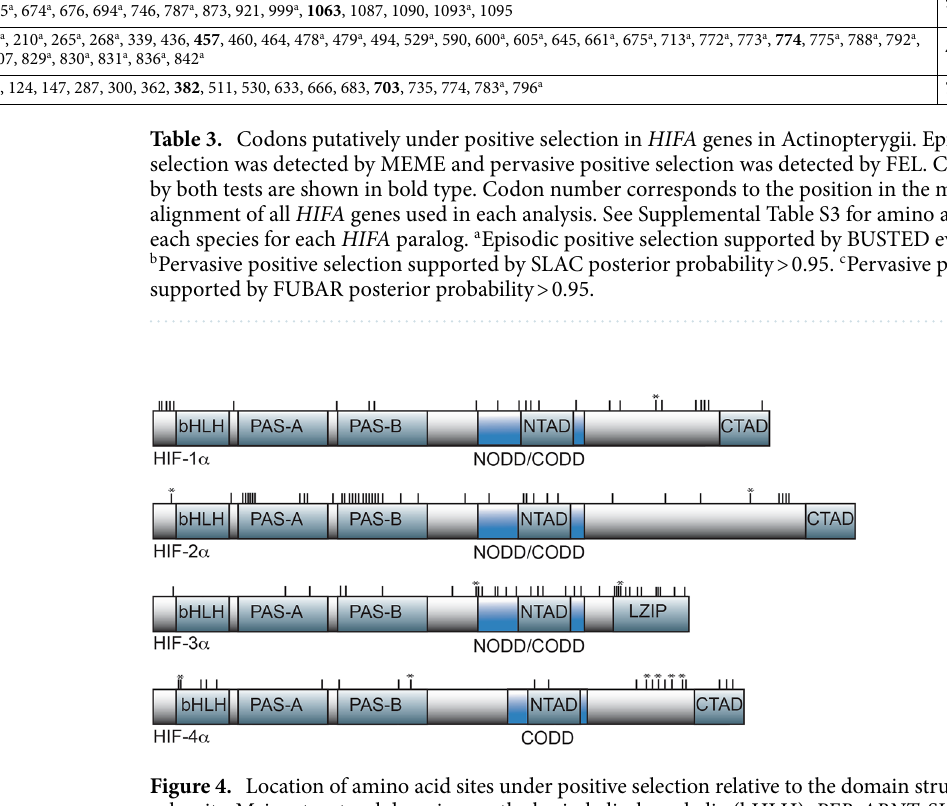
Figure 4. Location of amino acid sites under positive selection relative to the domain structure of HIFα subunits. Major structural domains are the basic-helix-loop-helix (bHLH), PER - ARNT - SIM (PAS-A, PAS-B), oxygen-dependent degradation (NODD and CODD), transactivation (NTAD and CTAD), and leucine zipper (LZIP) domains. The approximate locations of amino acid sites putatively under positive selection relative to these domains are shown with vertical hash marks above the domain models. The specific position and amino acid identity at each site in each HIFα subunit are given Supplemental Table S3. Asterisks indicate amino acid sites that are potentially under pervasive positive